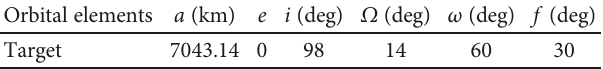
Table 1: State of the target.